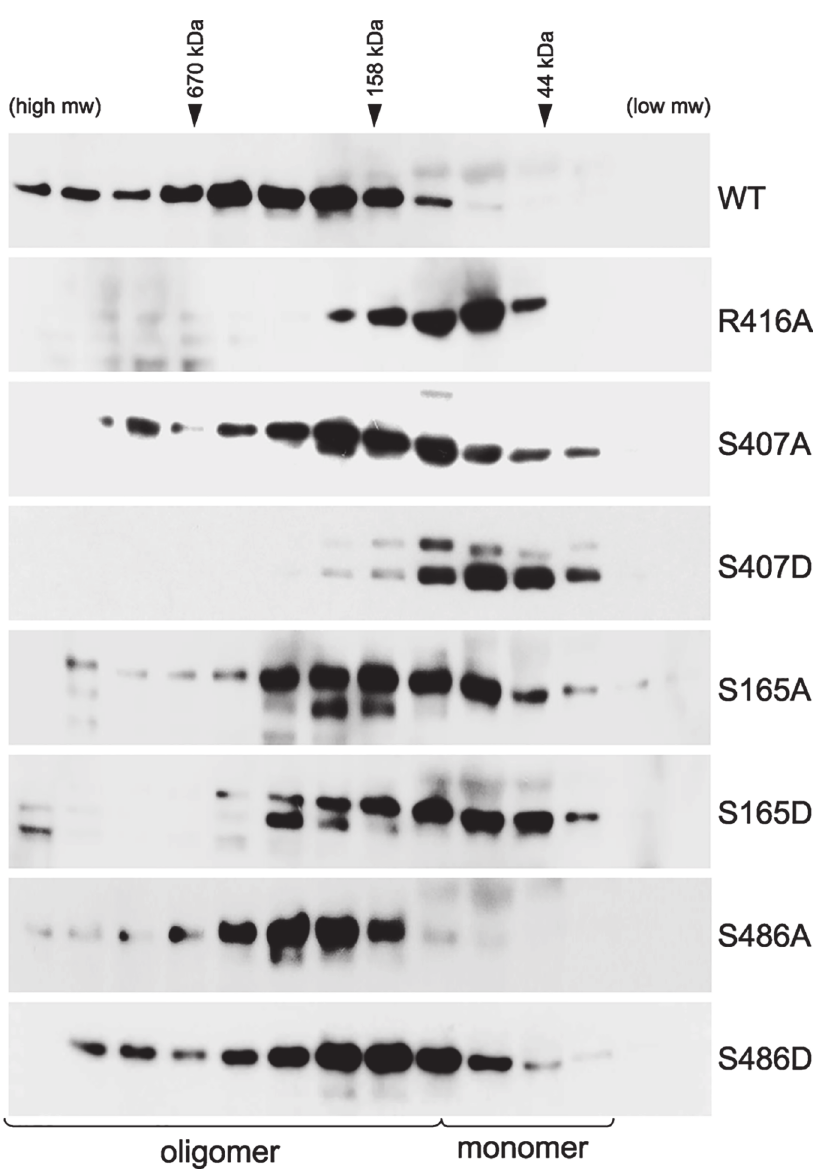
Fig 5. Critical serine residues control NP oligomerization in cells. Lysates were prepared from 293T cells expressing WT, mutant or phosphomimetic NP and fractionated by size exclusion chromatography. Fractions were analyzed by western blot with anti-NP antibodies. WT NP and the oligomerization defective NP R416A were used as internal standards to determine the position of the oligomeric and monomeric populations, respectively. Elution peaks for calibration standards are